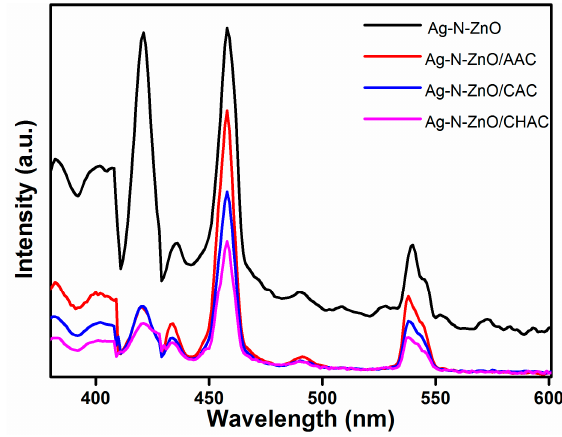
Figure 4. PL spectra of Ag-N-ZnO, Ag-N-ZnO/CHAC, Ag-N-ZnO/CAC and Ag-N-ZnO/AAC.